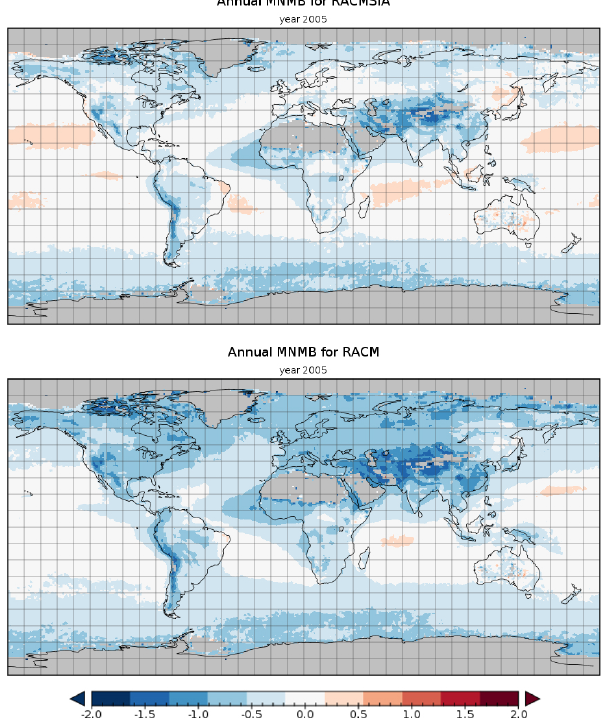
Figure 6. Maps of the annual modified normalized mean bias (MNMB) of aerosol optical depth against MODIS observations. The upper panel shows the RACM experiment, while the lower panel shows the RACMSIA experiment with secondary inorganic aerosols.